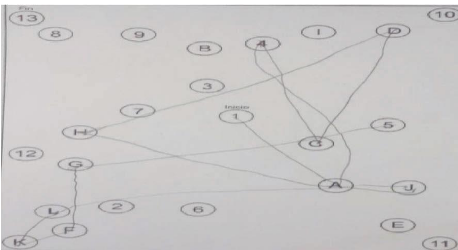
Figure 3: Trail making test (TMT) form B results. Duration: 3 ′ 47 ″ .